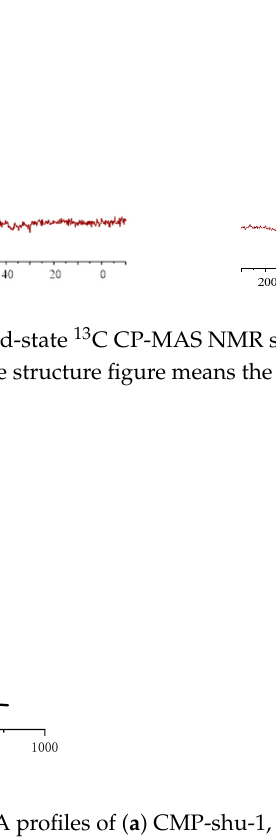
Figure 5. TGA profiles of ( a ) CMP − shu − 1, ( b ) CMP − shu − 2.